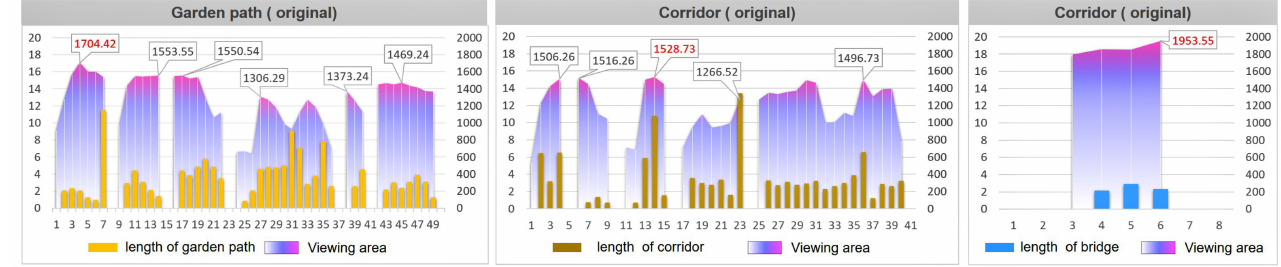
Figure 17. The superimposed comparison diagram of the length of one side of the road and the viewing area of the original garden path.